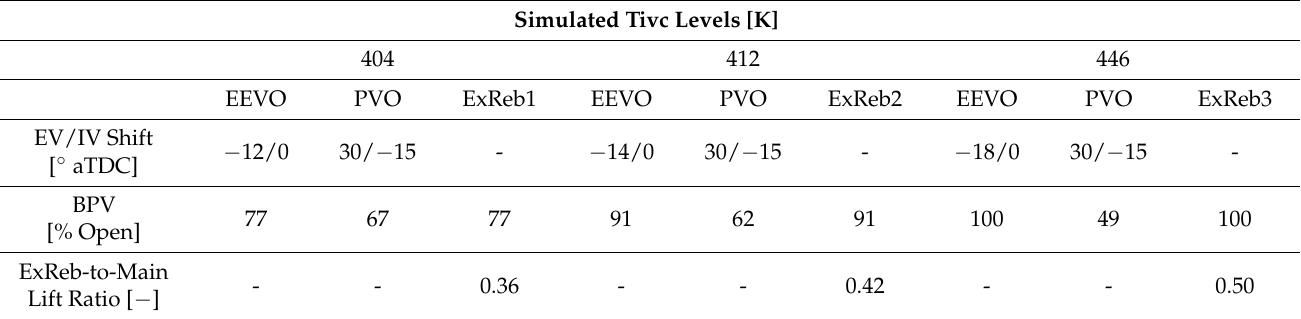
Table 5. Implemented valve variability and the BPV positions for the EEVO, PVO, and ExReb strategies at